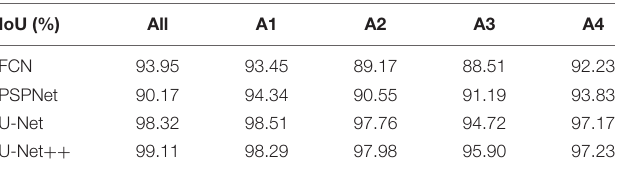
TABLE 2 | Segmentation results on each sub-dataset and their com- bination using different basic architectures.